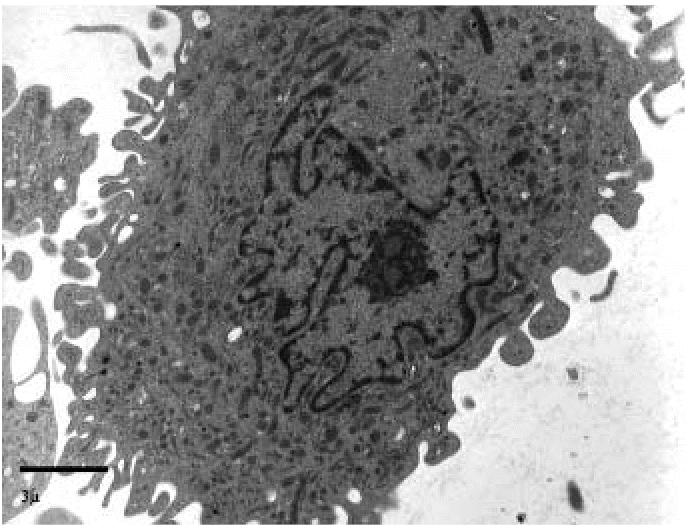
Transmission electron micrograph showing small macrophages, the cytoplasm of which contains prevalently primary lysosomes (exposed subject). Bar = 3 μm.